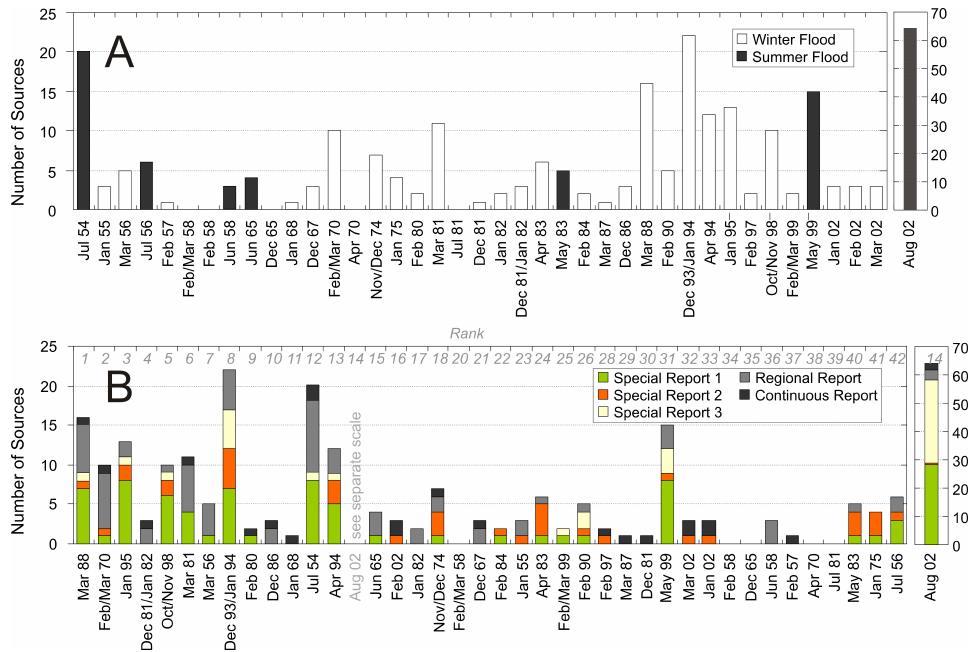
Fig. 4. Number of documents per event for the top 40 trans-basin floods in Germany. (A) In chronological order; (B) in order of trans-basin flood severity and stratified by report typology. The August flood of 2002 is displayed at a separate